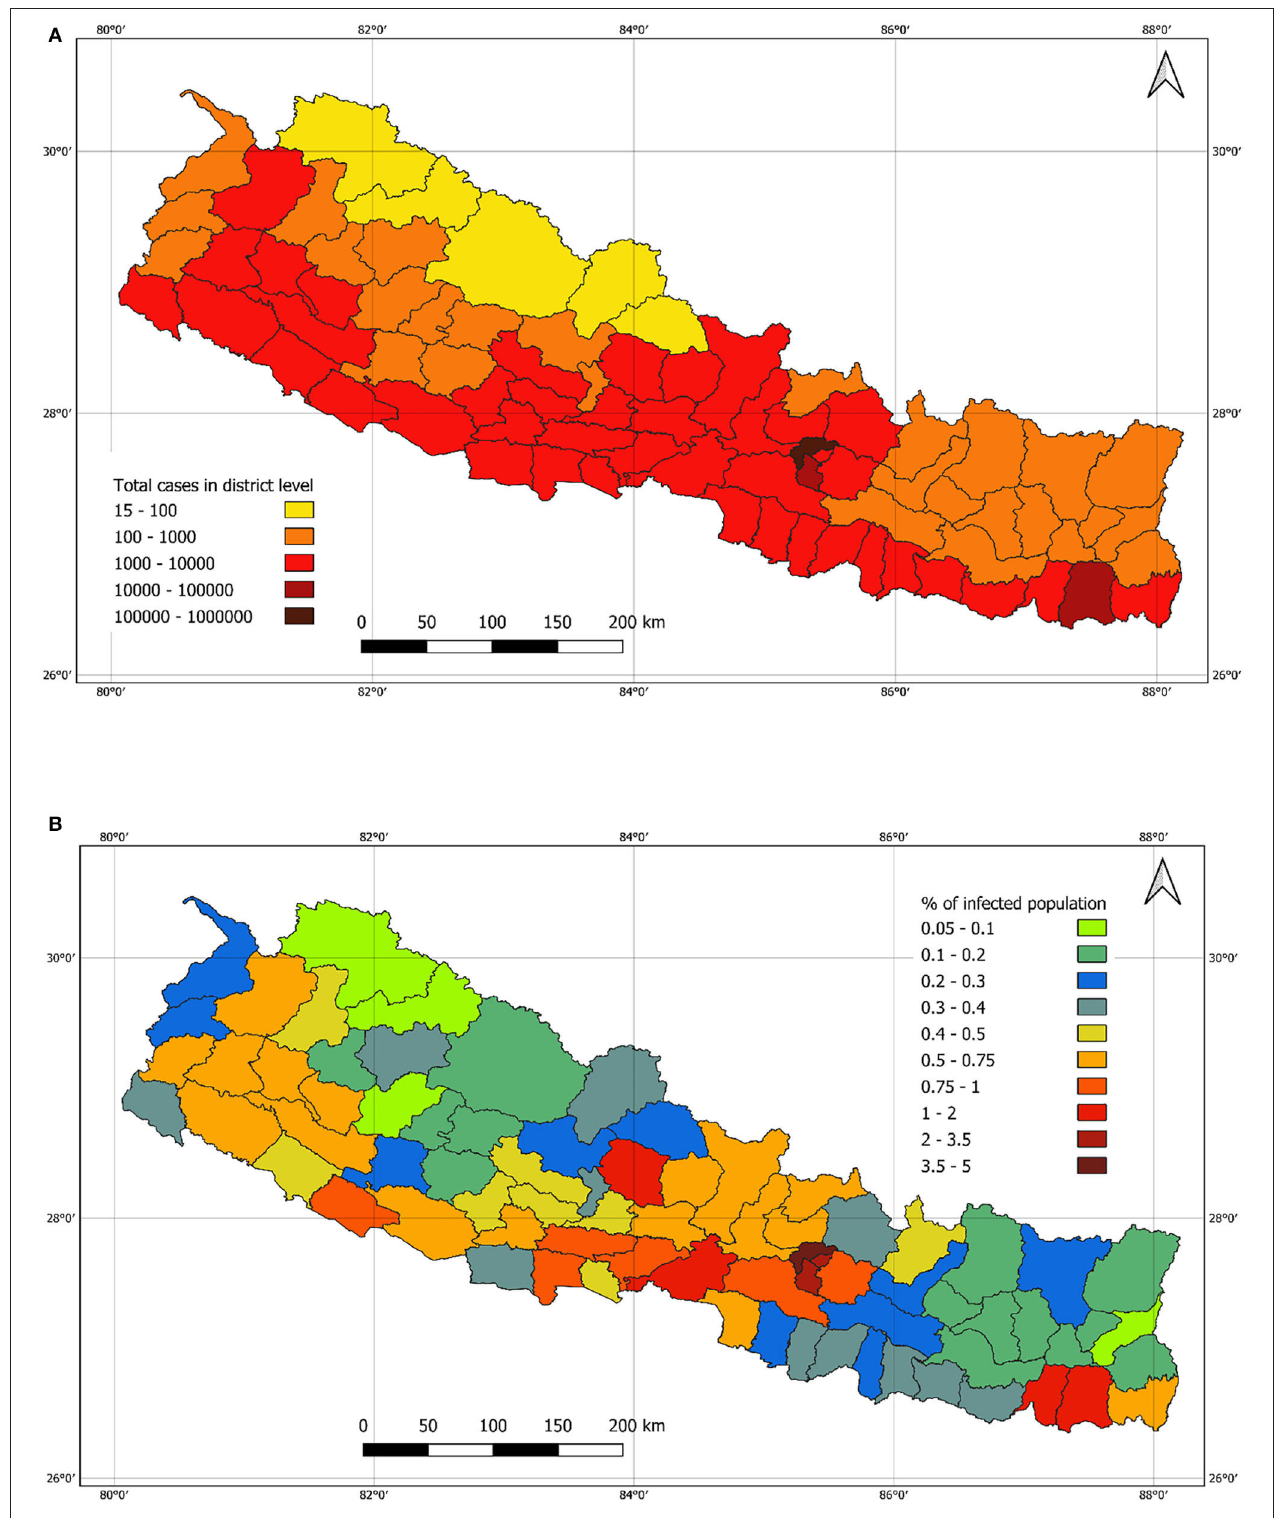
FIGURE 10 | (A) : Number of cases in district level as of 01 March 2021. (B) : Population infection rate in district level as of 01 March 2021.